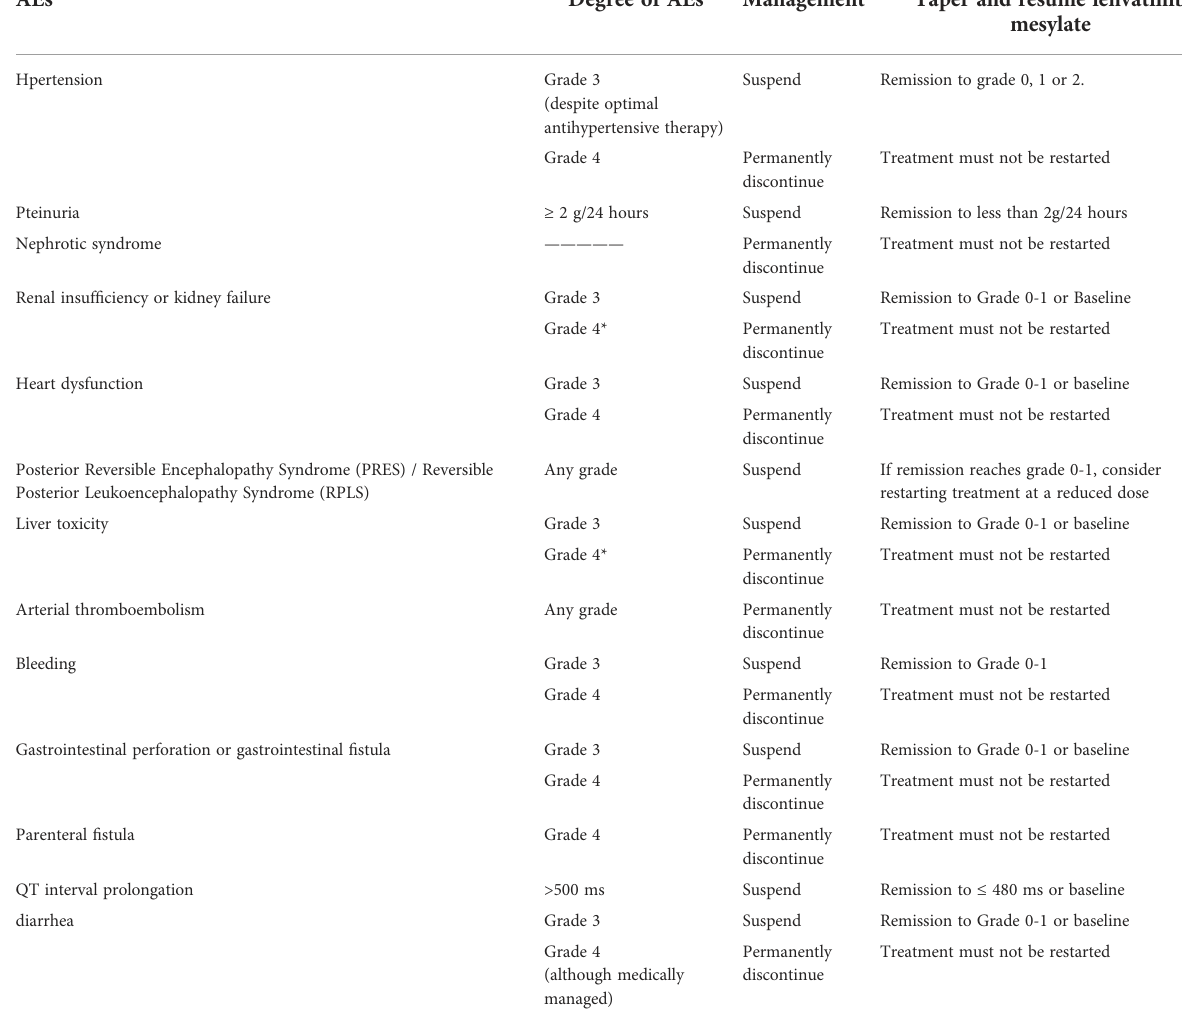
TABLE 2 Dose adjustment criteria of lenvatinib according to the